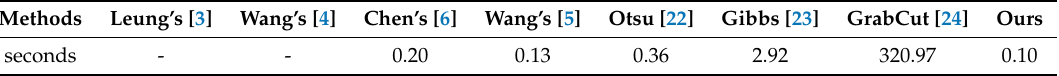
Table 4. Average time cost of methods mentioned in this paper for processing an